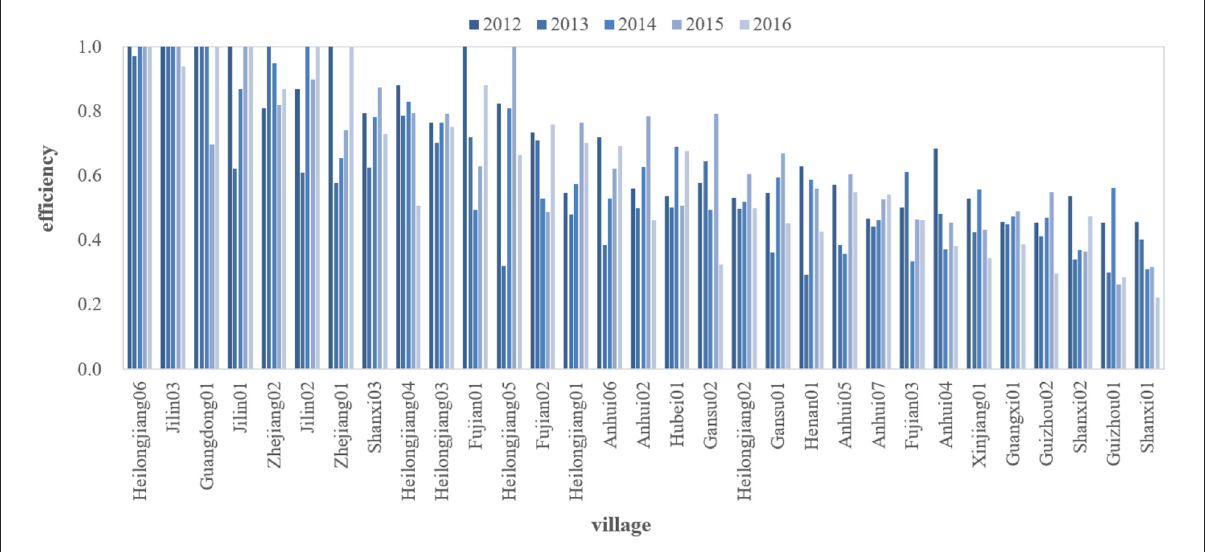
FIGURE3 Overall efficiency from 2012 to 2016.